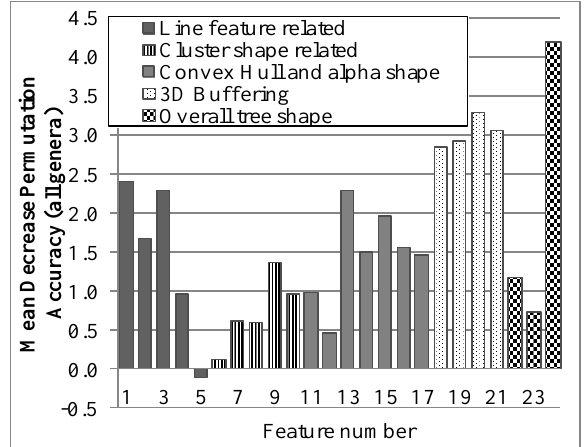
Figure 3. The mean decrease permutation accuracy for all genera for geometric derived features using 30% of the data for